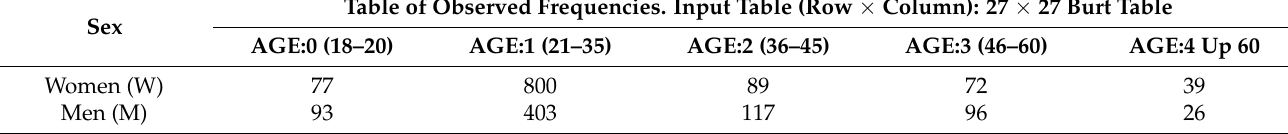
Table 2. Number of respondents divided by age and sex. Table of Observed Frequencies. Input Table (Row × Column): 27 × 27 Burt Table